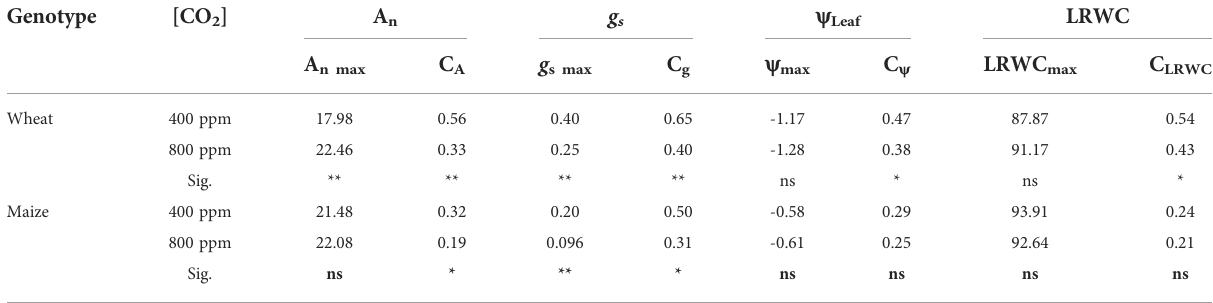
TABLE 1 Signi fi cant test for linear-plateau model parameters of net photosynthetic rate (A n ), stomatal conductance ( g s ), leaf water potential ( y Leaf ), and relative leaf water content (RLWC).